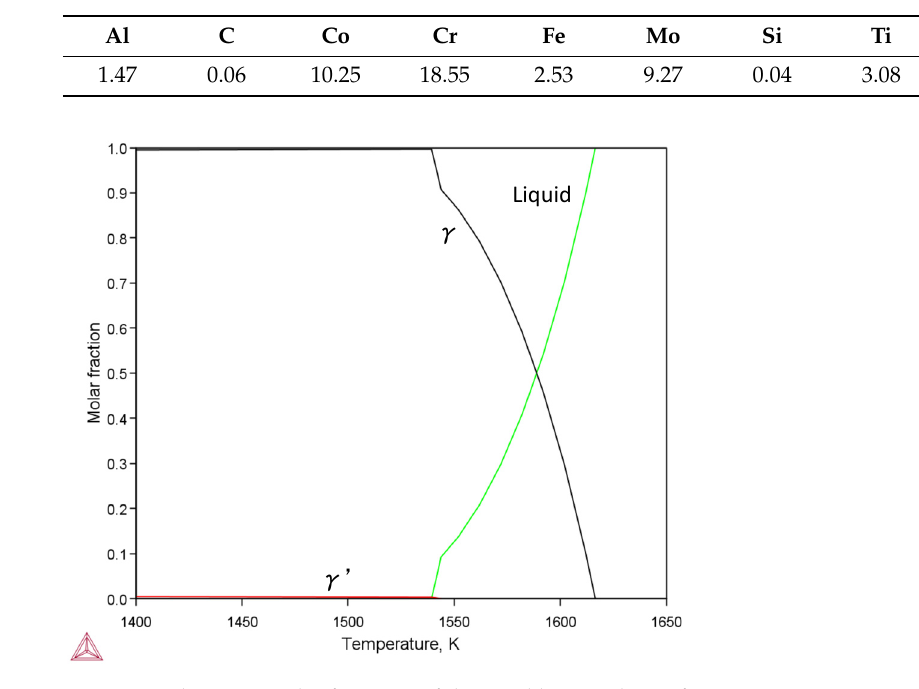
Figure 5. Schematic molar fractions of the equilibrium phases for temperature. Table 3. Estimated cooling rate and temperature gradient at p1, p5, and p10 in Figure 1b. Layer Position Cooling Rate, K/s Temperature Gradient, K/m